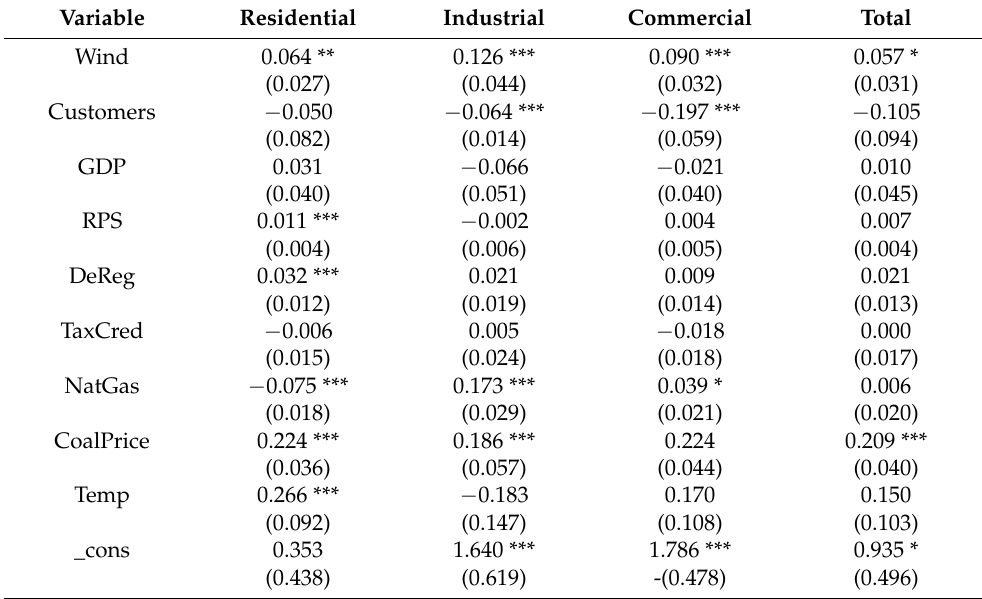
Table 2. Fixed effects model. Electricity price dependent variable.